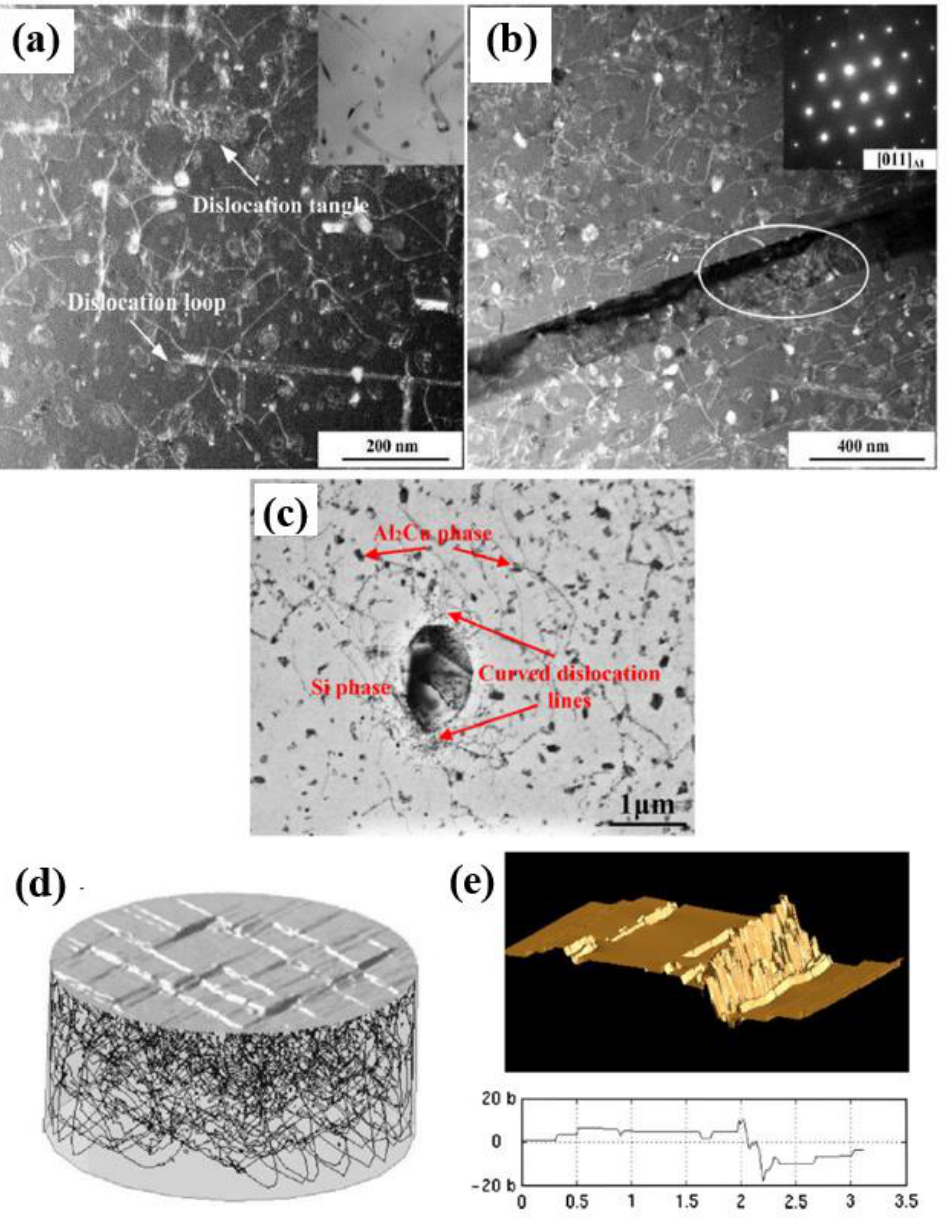
Figure 16. TEM images showing dislocation structures in ( a ) Al-7%Si-0.3%Mg and ( b ) Al-7%Si- 0.3%Mg-0.2%Zr alloys after LCF at a strain amplitude of 0.3% and 300 °C [290]. ( c ) TEM images of interactions between dislocation lines and eutectic Si phase in an A319-T6 alloy [62]. Surface mor- phology of post-cyclic loading showing ( d ) dislocation arrangements and ( e ) extrusions/intrusions by discrete dislocation simulations [319]. Reproduced with permission from